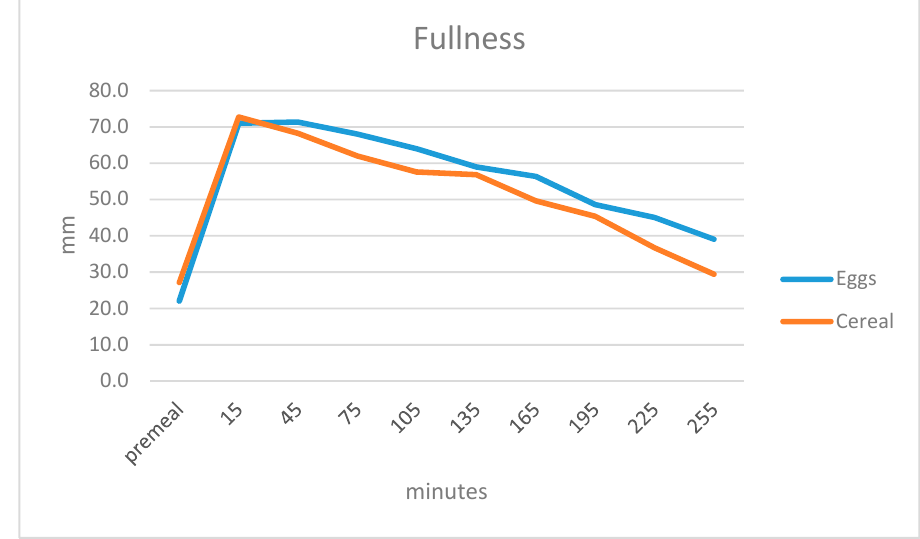
Figure 3. Subjective sensations of fullness before and 15, 45, 75, 105, 135, 165, 195 and 225 min after finishing breakfast on a 100-mm VAS scale.